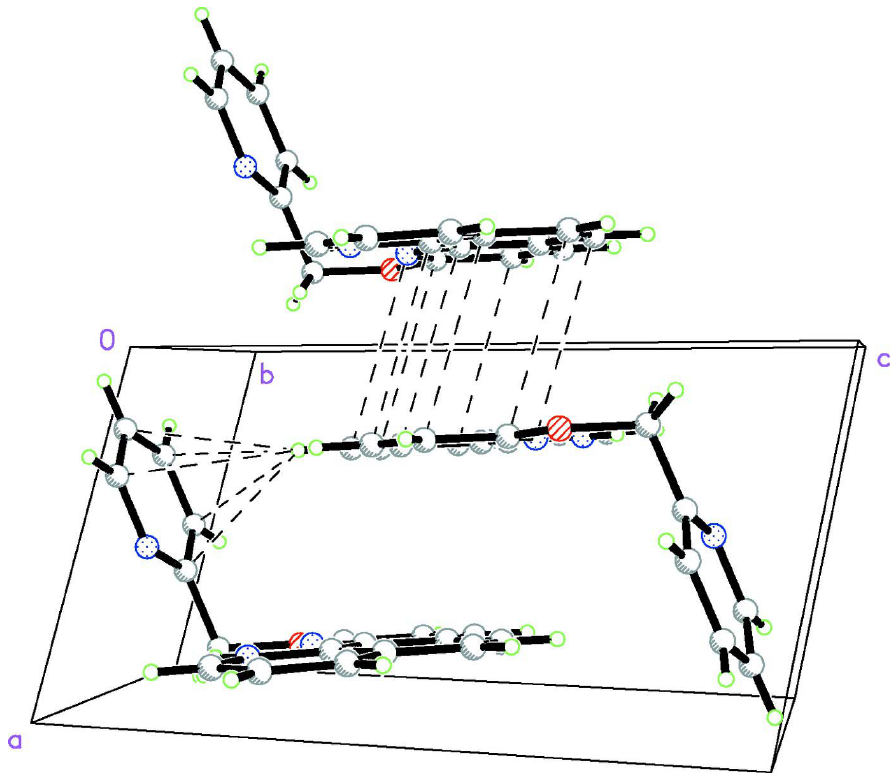
Figure 2 The packing and π - π stacking interaction (dashed lines) and C—H··· π interaction (dashed lines), the methanol molecule and perchlorate anion have been omitted for